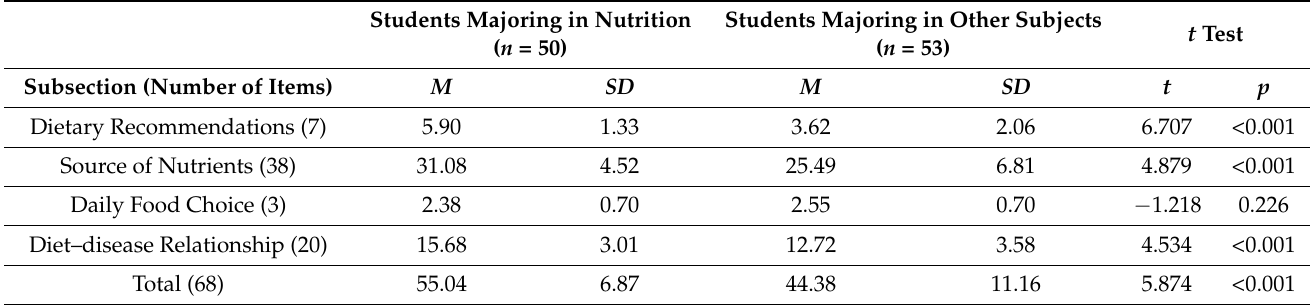
Table 2. Comparison of C-GNKQ scores between participants with different nutrition education.